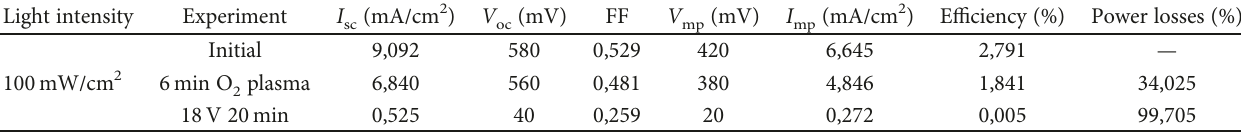
plasma application. 2